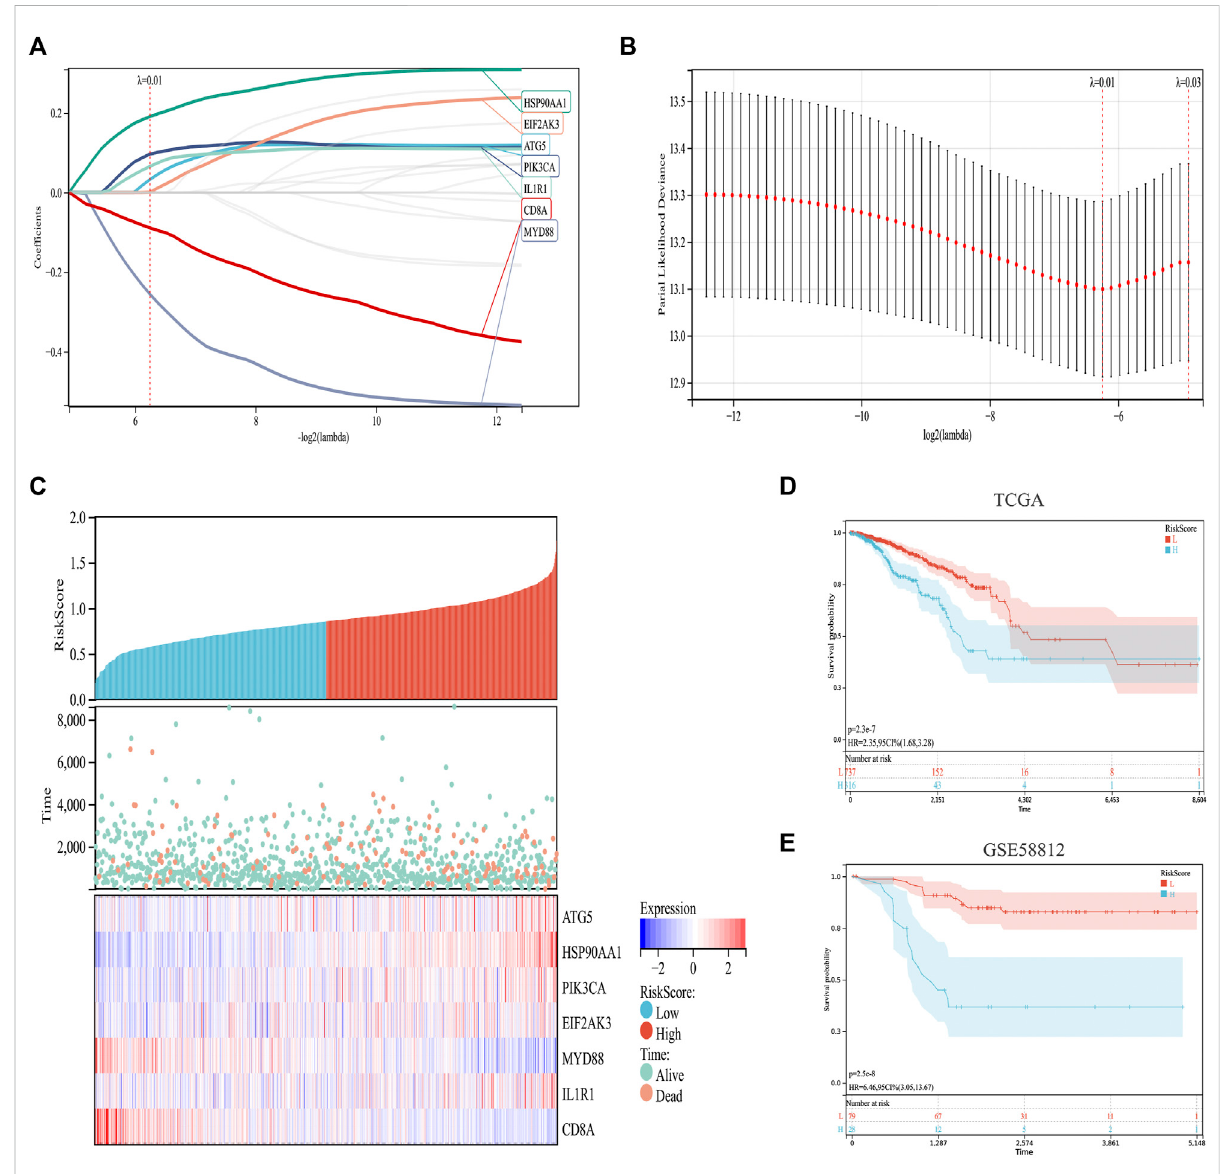
FIGURE 4 Construction and validation of an ICD risk model. (A,B) Lasso-Cox analysis identi fi es seven ICD genes associated with overall survival in BC. (C) Prognostic heatmap showing the relationship between different risk scores of the ICD risk model, patient survival events, and changes in gene expression. (D,E) Survival analysis plot showing the risk model has valid prognostic signi fi cance in both the TCGA ( p = 2.3 × 10 − 7 ) and GSE58812 ( p = 2.5 × 10 − 8 )